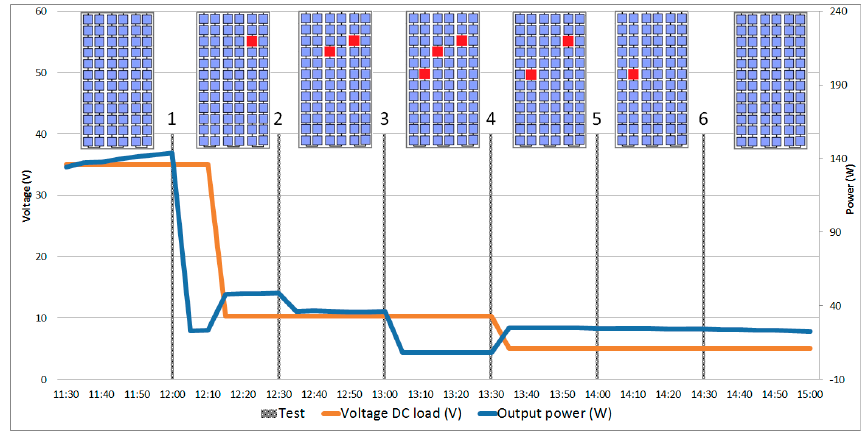
Figure 9. Programmable DC electronic load voltage imposed and output power in test 2.